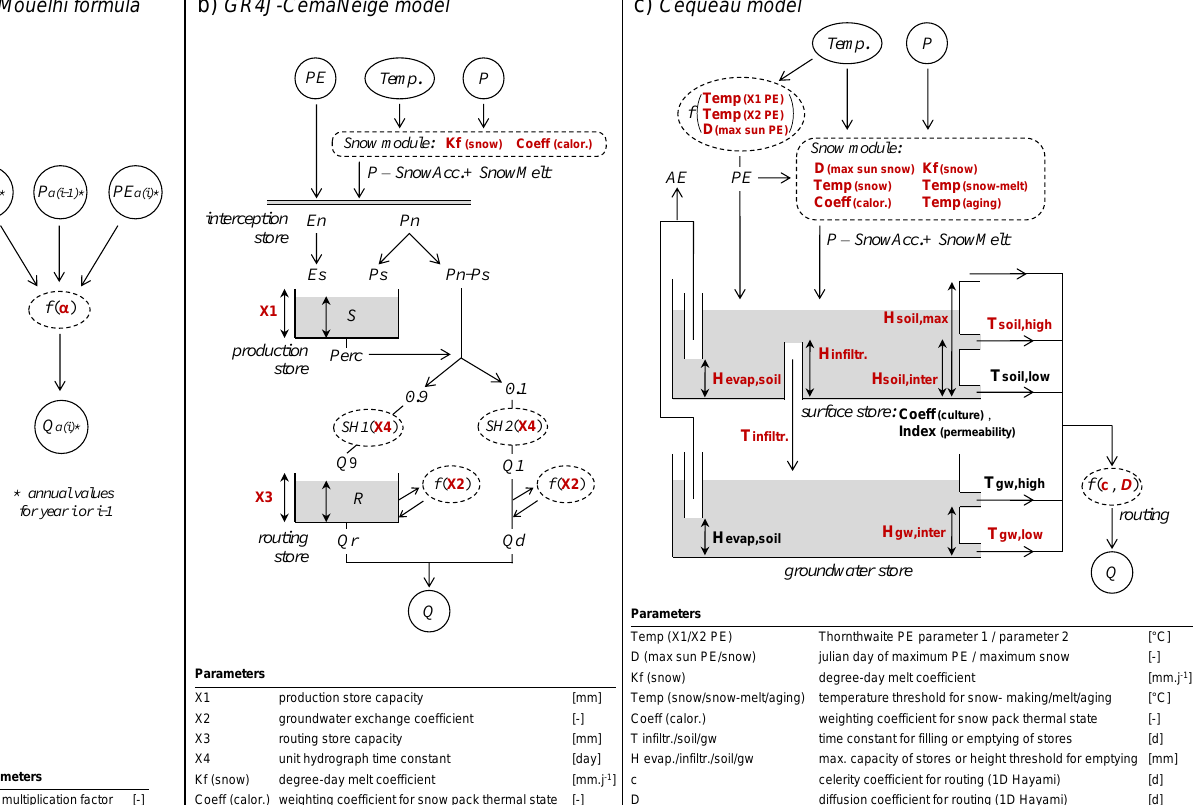
Fig. 2. Structural schemes of the three models tested: (a) the Mouelhi formula, (b) GR4J-CemaNeige and (c) Cequeau (optimised parameters are in red bold